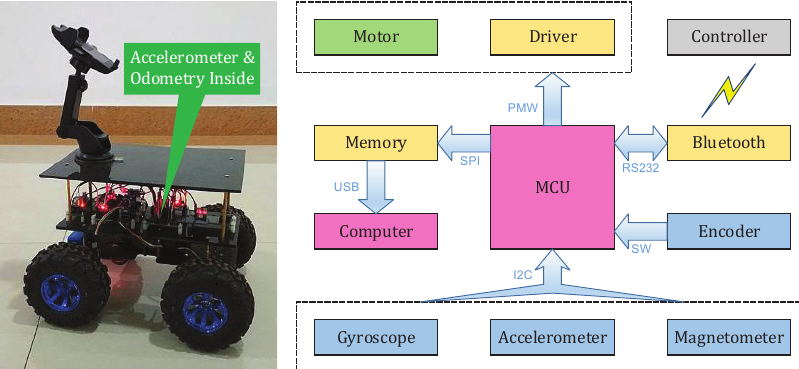
Figure 2. A four-wheeled mobile robot for experiment. The left figure shows the robot photograph, and the right one shows its electronic system structure and signal